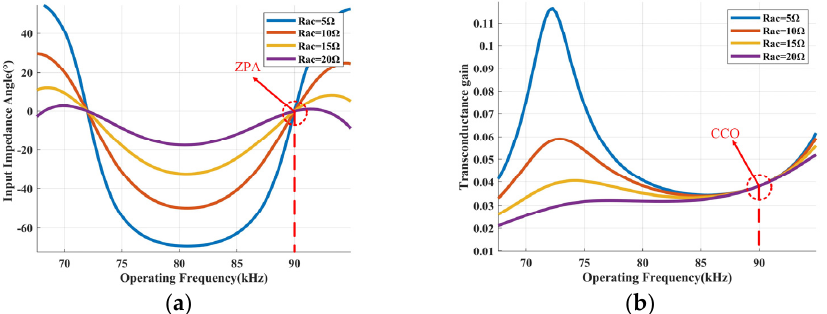
Figure 7. Transconductance gain and input impedance angle of the proposed LC/S compensated IPT system. ( a ) Input Impedance Angle; ( b ) Transconductance gain.